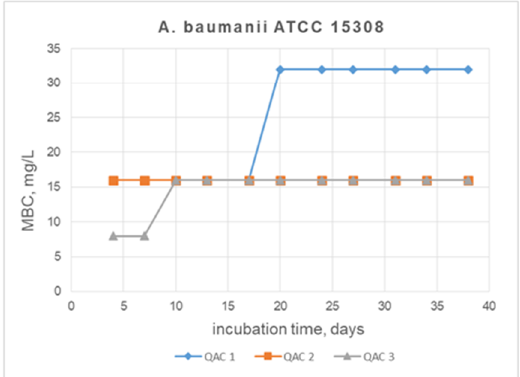
Figure 2. Resistance study. Graphs show the growth of QACs bactericidal concentrations with increasing incubation time on each pathogen.